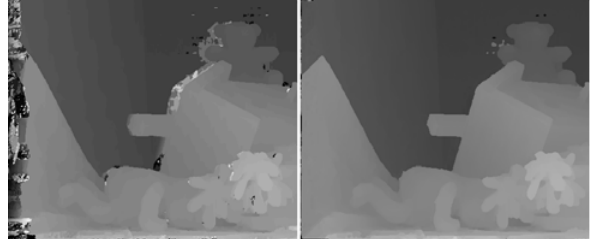
Figure 6. Disparity map of the Teddy reference image before (left) and after (right) the overall refinement.